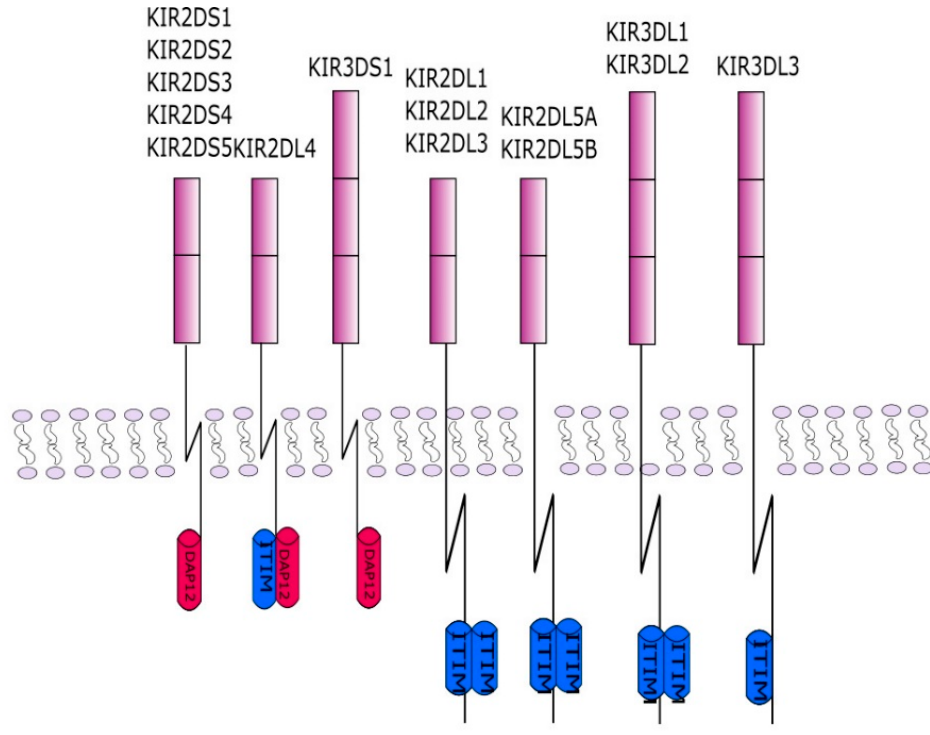
Figure 3. This figure shows the KIR protein structures. Each of the receptors consists of two or three protein domains and a long or short cytoplasmic chain. The chain in inhibitory KIRs is associated with an ITIM inhibiting sequence. The activating KIRs interact with the adapter DAP12 containing ITAM sequences. The interaction takes place through a charged amino acid in the KIR transmembrane